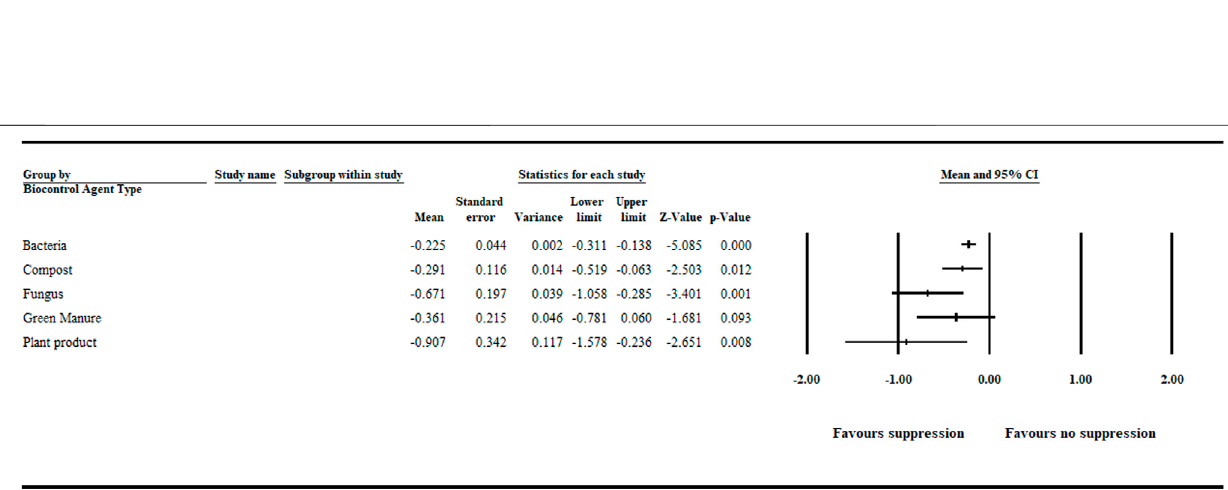
FIGURE 4 | Effect of biocontrol agent type on aphanomyces root rot suppression. The analysis detected a signi fi cant ( p < .05) negative effect size for bacterial, compost,fungalandplantproducttreatments.Numberofstudies:Bacteria93;Compost9;Fungus26;Greenmanure16;Plantproduct12.Thecenterofthehorizontal line depicts the effect size, and the width re fl ects its con fi dence interval. CI (cid:1) con fi dence interval.